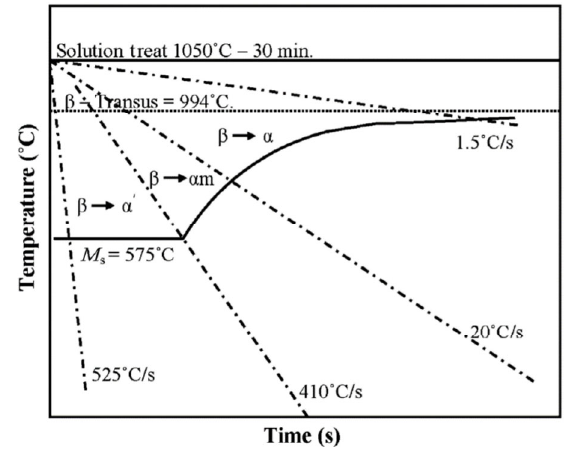
Fig. 2 The phase transition diagram of Ti64 based on the rate of cooling. Reproduced with permission from Ref. [55]. Copyright Elsevier,